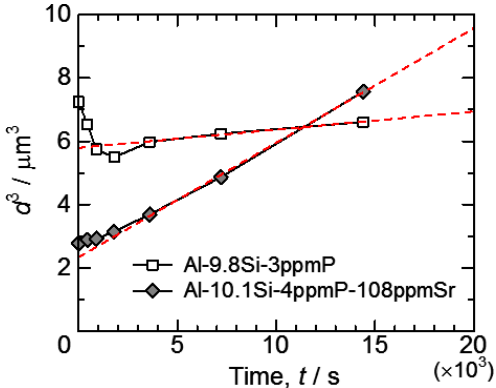
Figure 10. The relationship between cube of average particle size and annealing time.